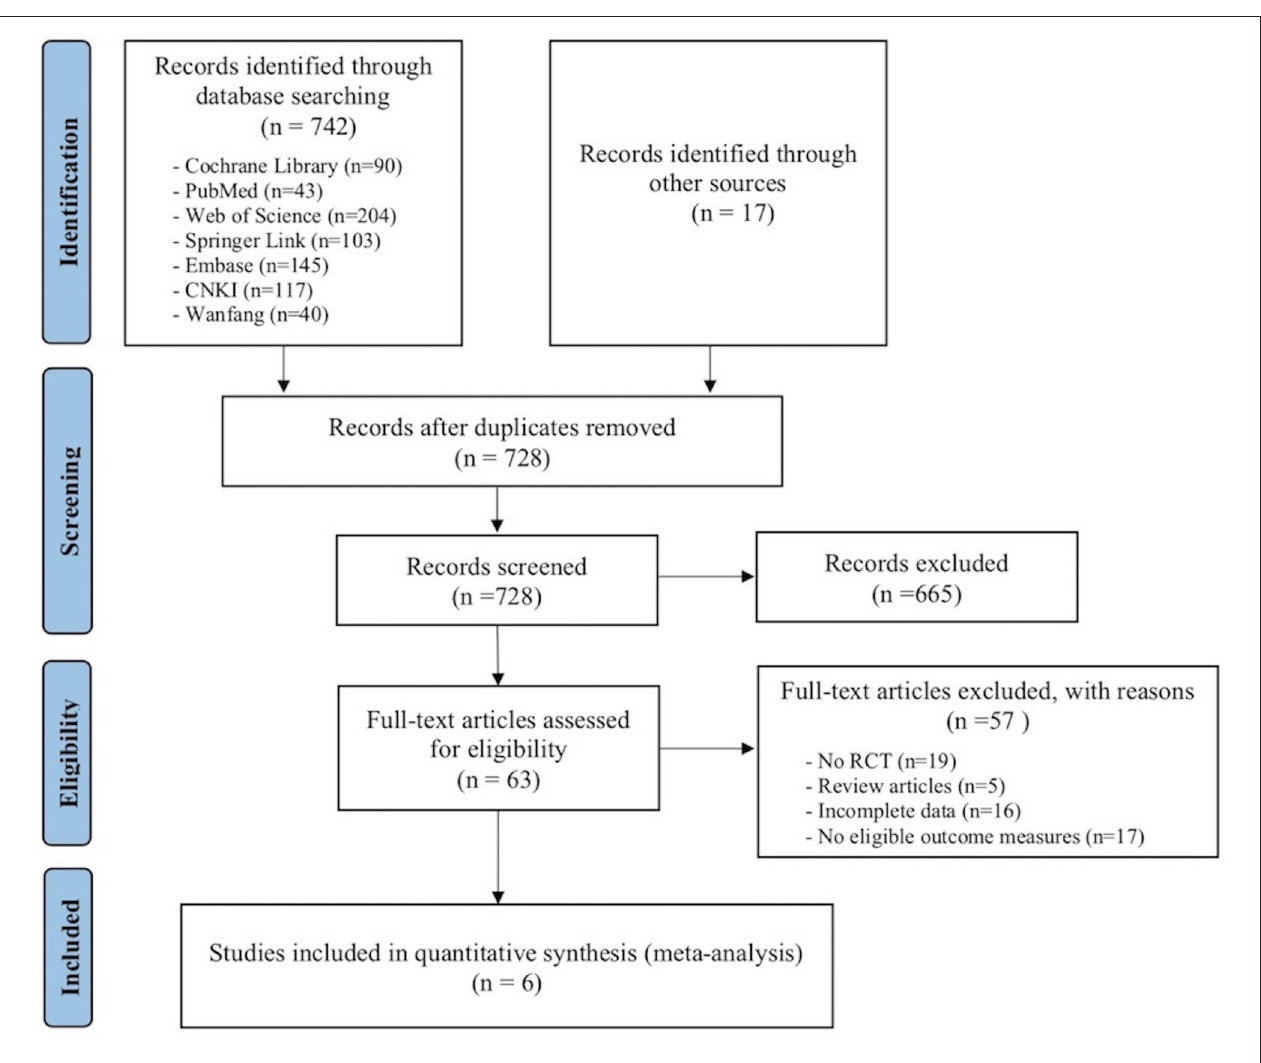
FIGURE 1 | Flowchart of study selection